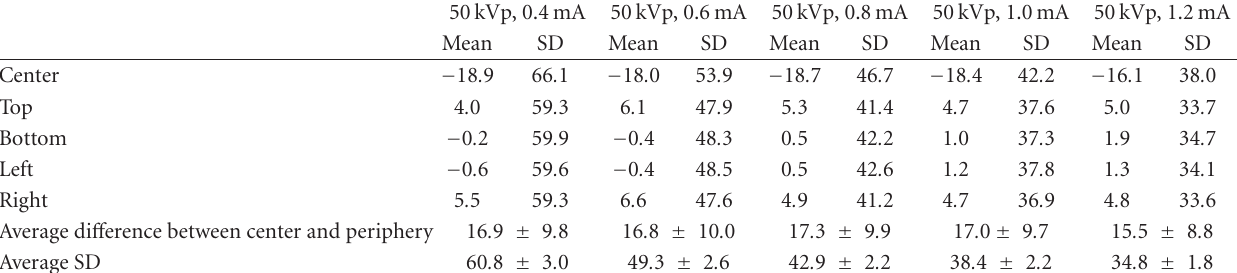
Table 2: Mean value and standard deviation (SD) in di ff erent five ROIs with di ff erent exposure intensities (in HU).